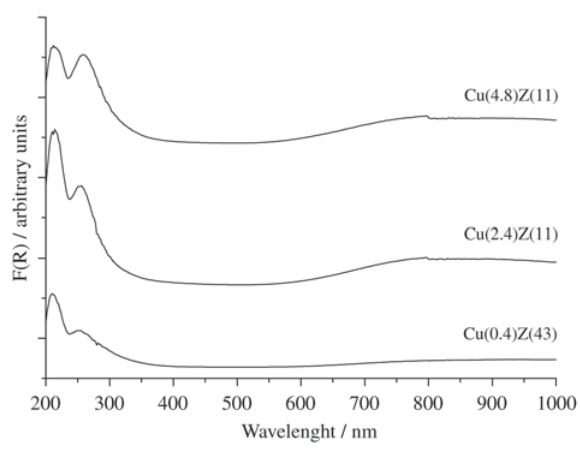
Figure 5. DRS-UV-VIS spectra of activated Cu/ZSM-5 catalysts.